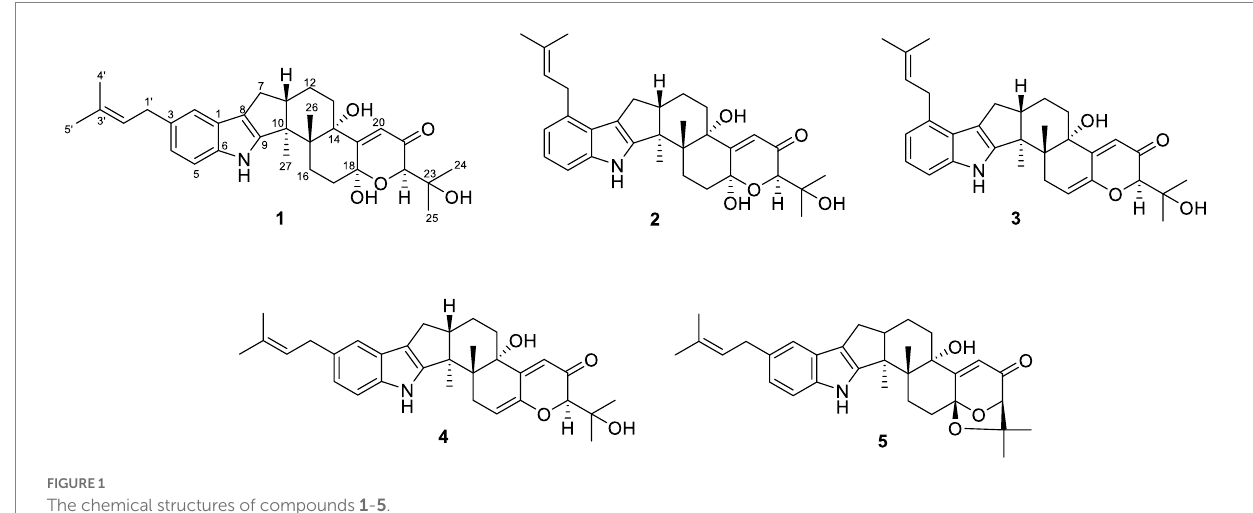
FIGURE 1 The chemical structures of compounds 1 - 5